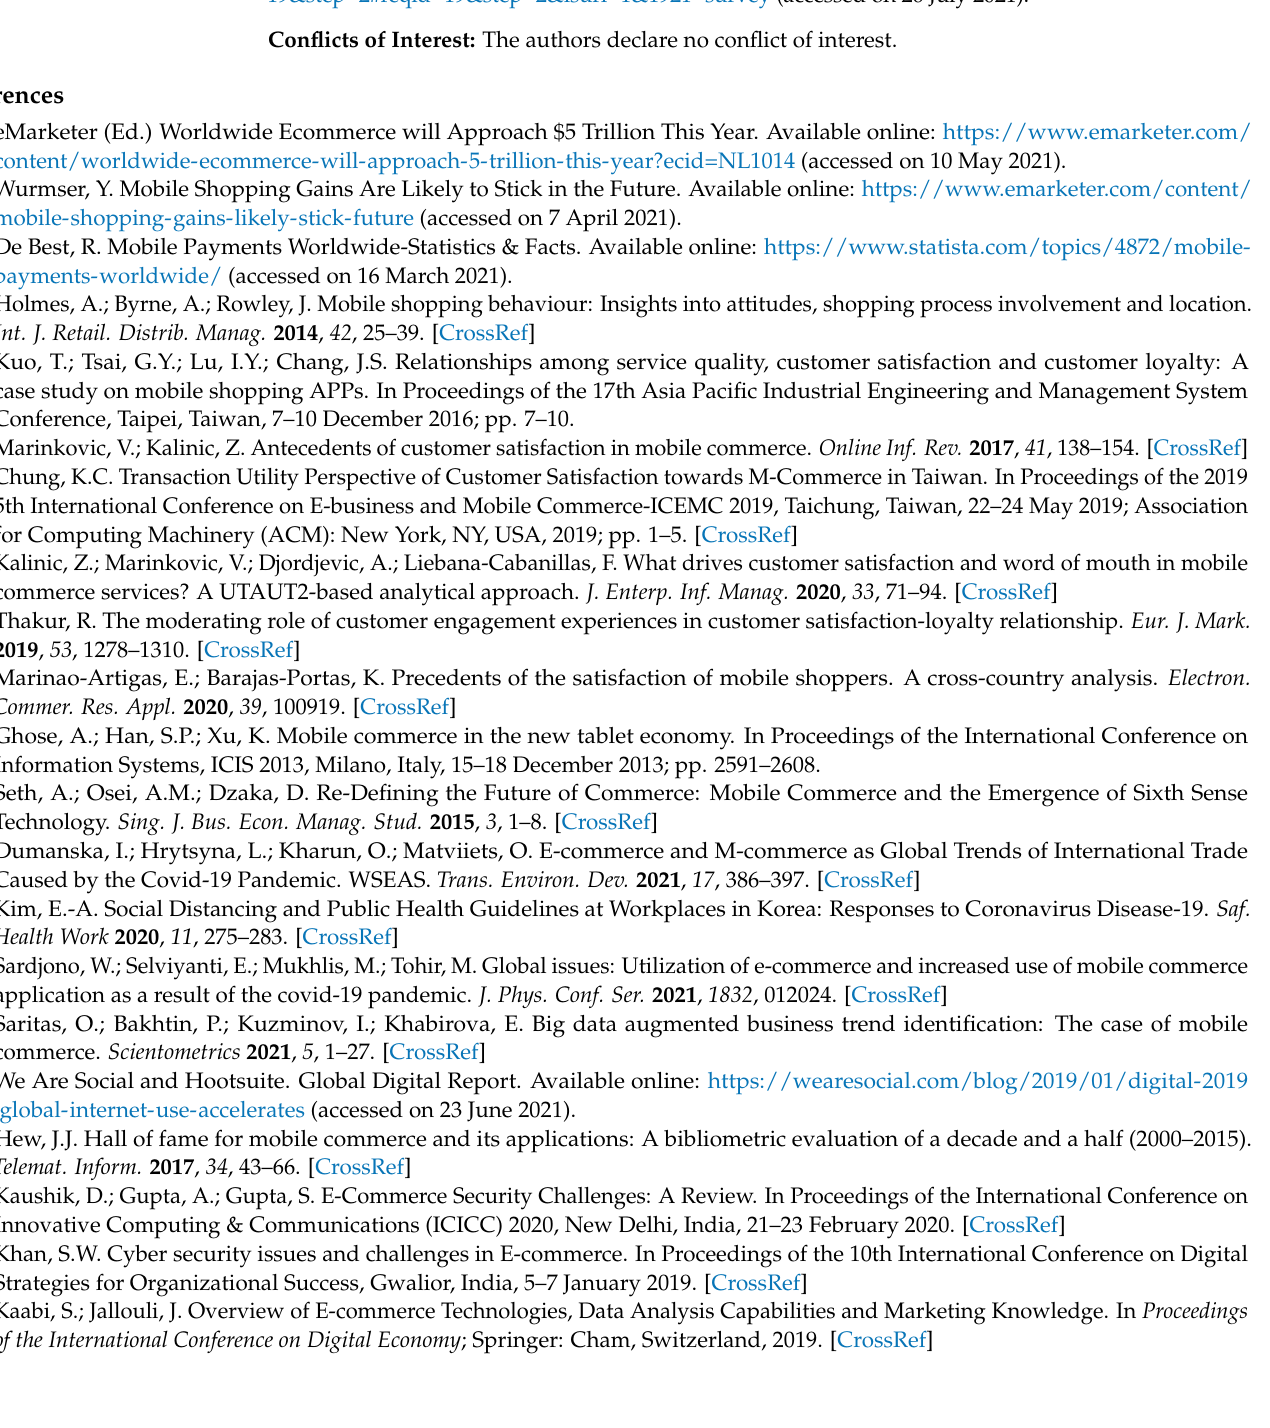
Domestic Product; Table 1.1.5. Gross Domestic Product,